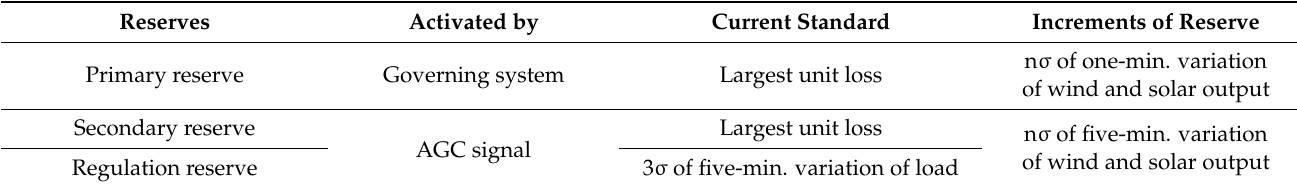
Table 3. Allocation method of the increment amount of reserve requirement.